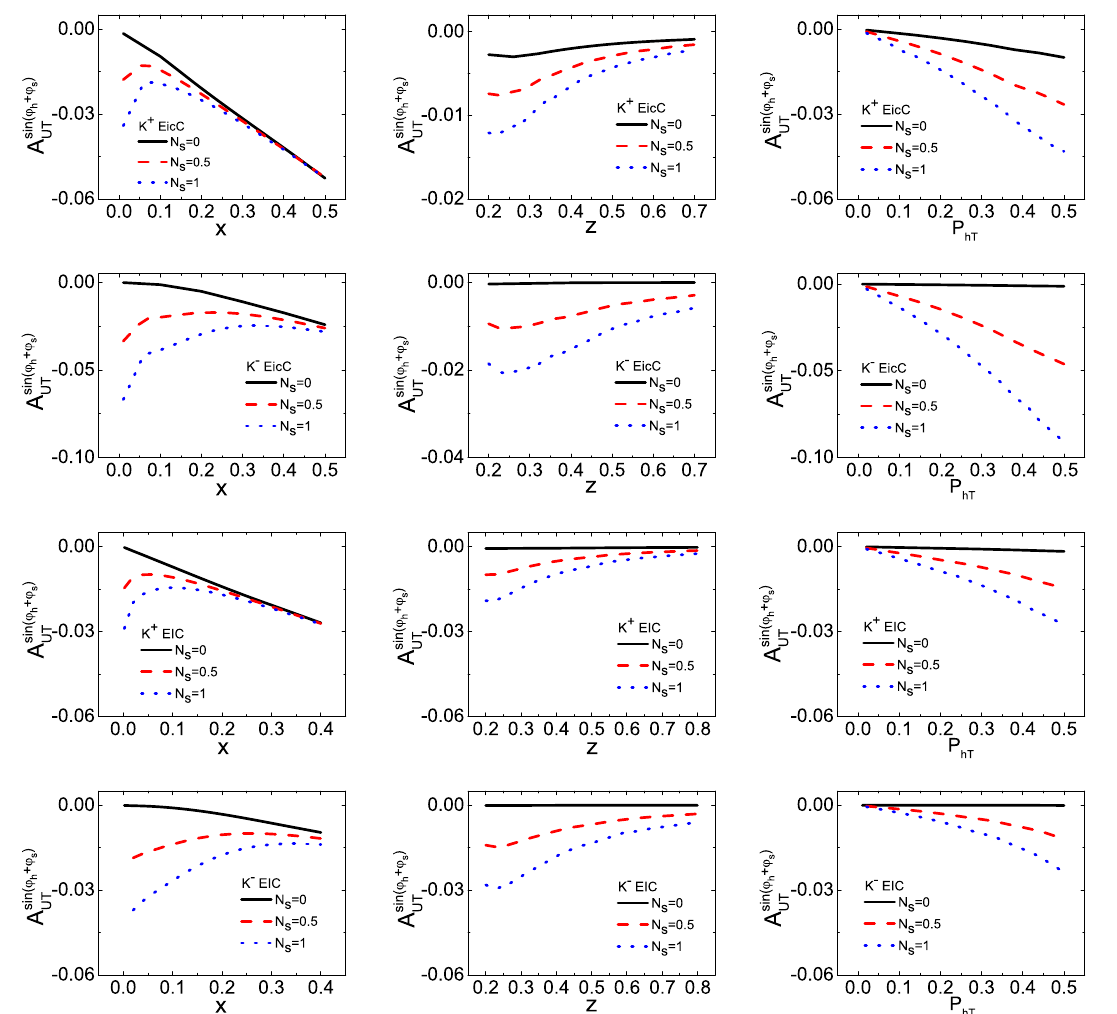
Fig. 2 The Collins asymmetry in semi-inclusive Kaon production SIDIS at the kinematics of EIC and EicC as functions of x (left panels), z (middle panels), and P hT (right